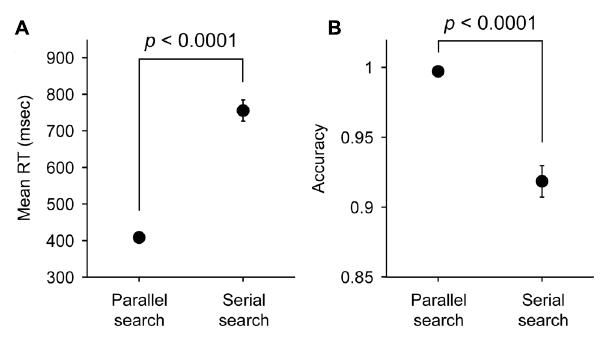
FIGURE 2 | Mean RTs (A) and accuracy (B) in parallel and serial search tasks. Error bars represent